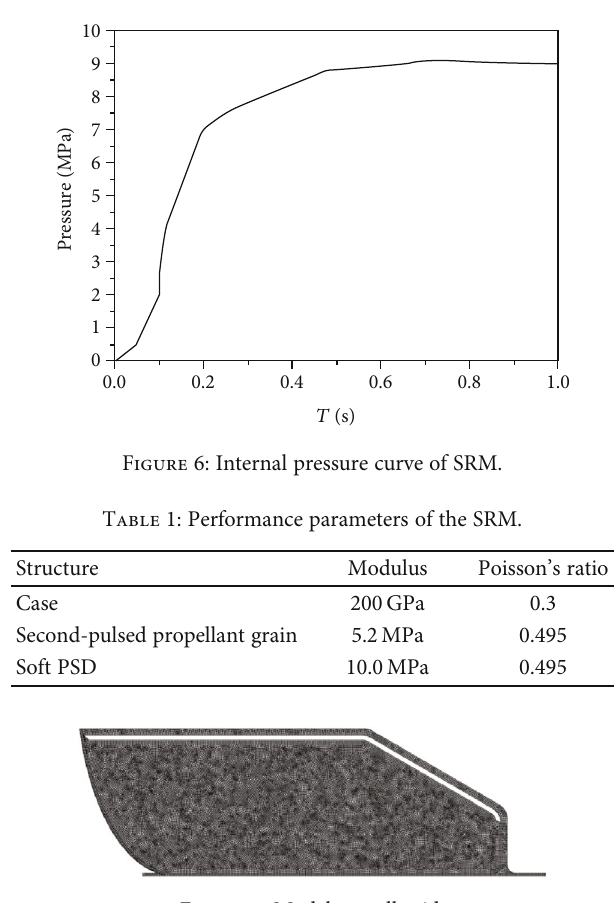
Figure 5: Second-pulsed propellant grain stress.